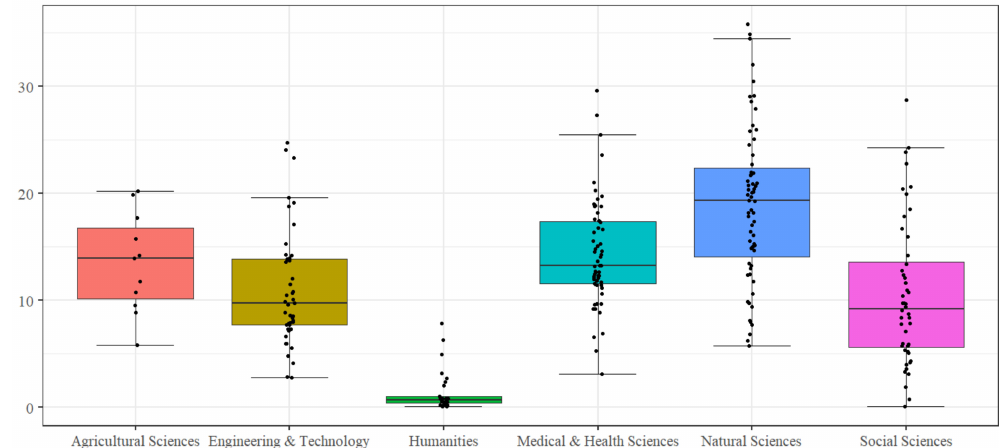
Figure 2. Boxplot of citations per publication for six main areas. (Each dot in the boxplot represents one Web of Science (WoS) subject category in the related OECD subject. The average citations per paper for 6 main and 39 s-level OECD subjects are shown in Appendix